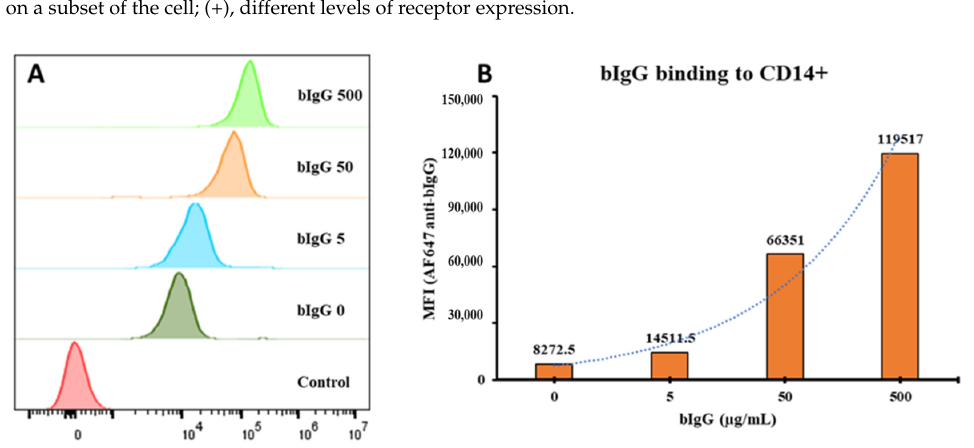
Table 2. Direct binding of bIgG and bIgG-immune complexes to monocytes.